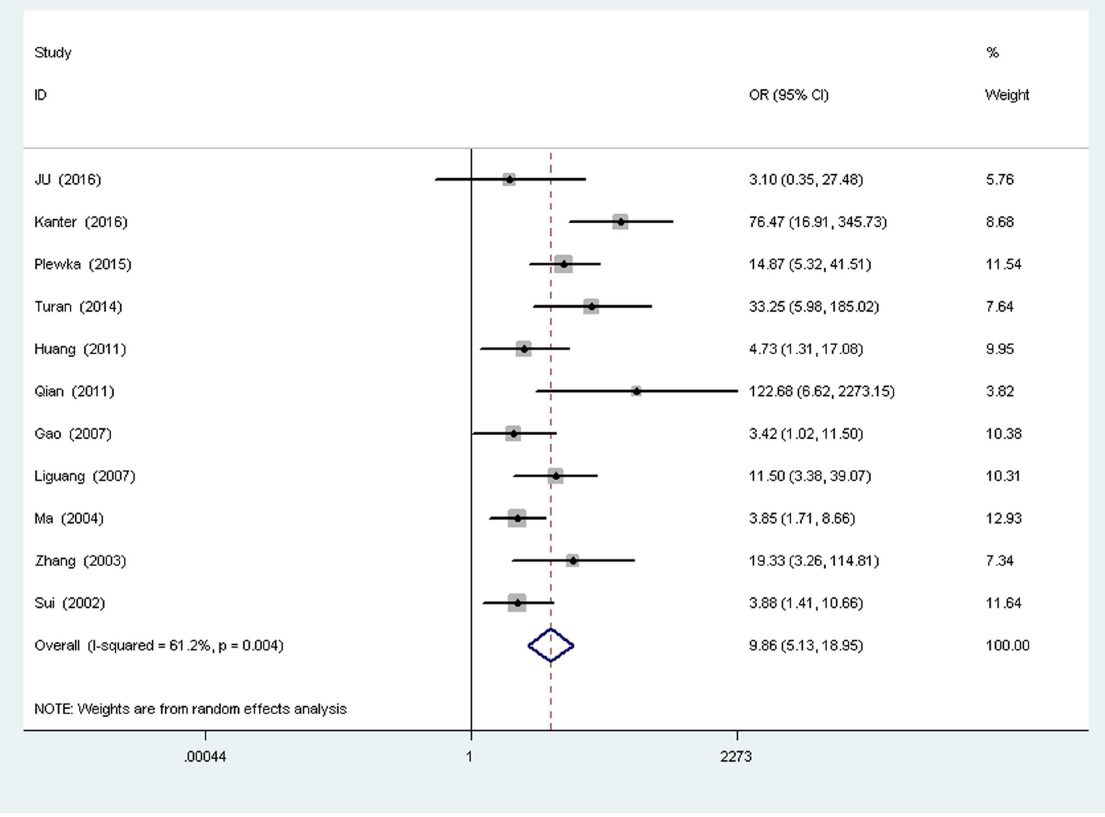
Fig 3. Forest plot depiction of survivin expression and odds ratio (OR) for ovarian carcinoma vs ovarian benign tumor.